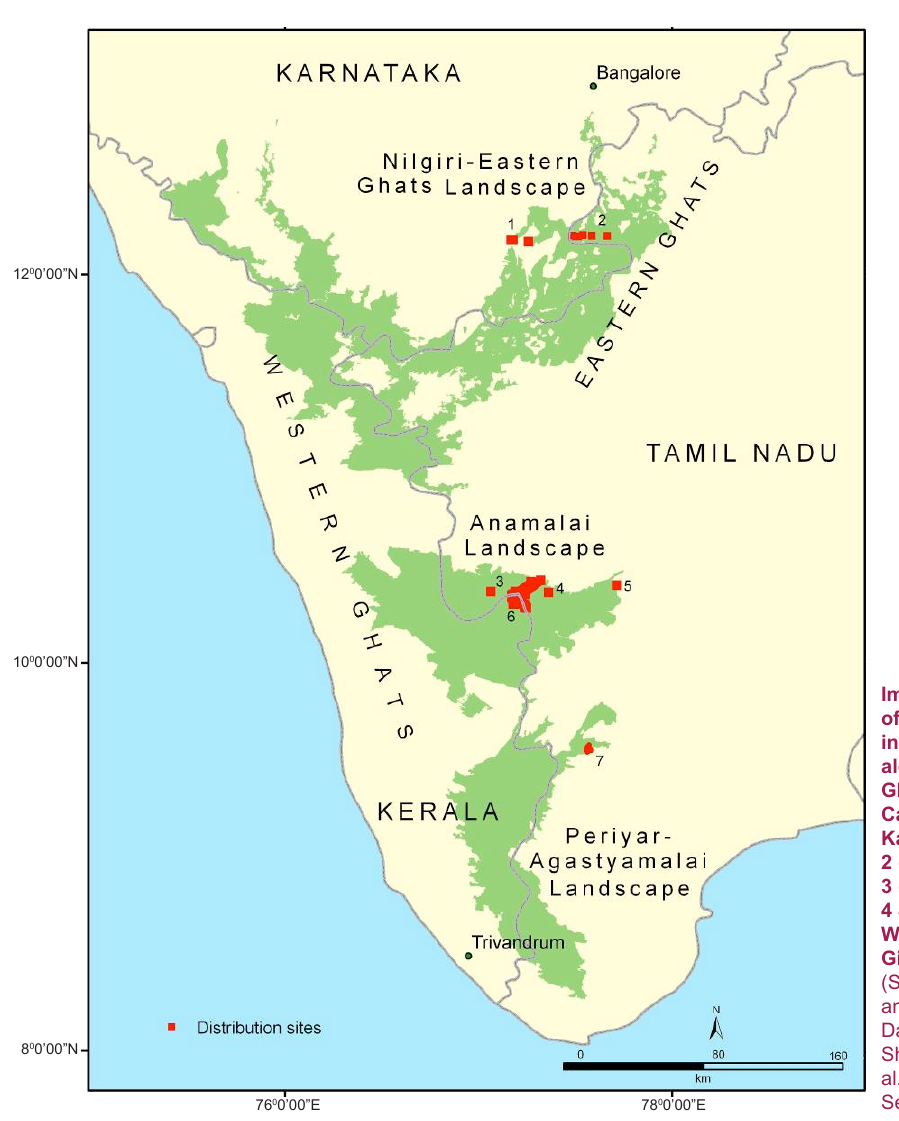
Image 3. The distribution of Grizzled Giant